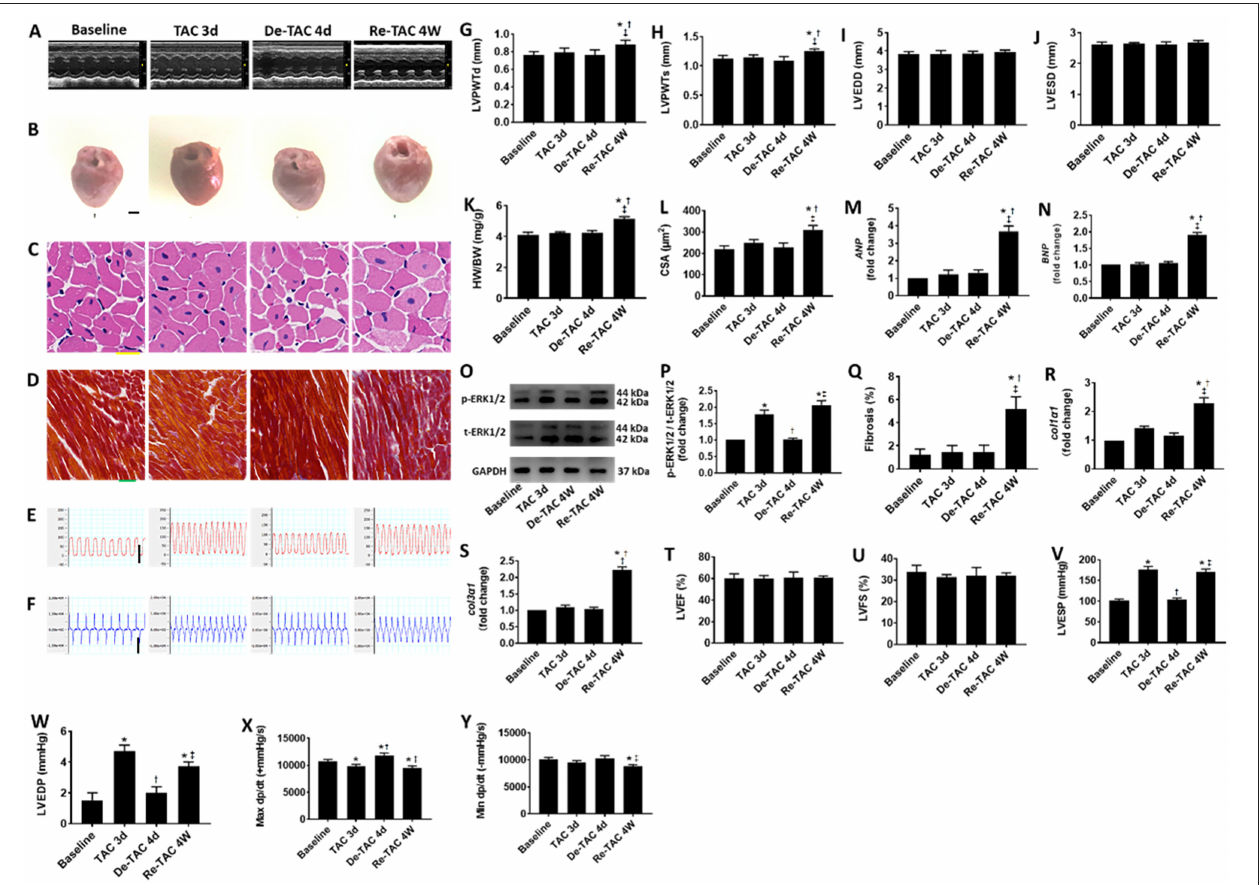
FIGURE 3 | Serial assessment of cardiac morphological and functional changes in HP murine hearts. (A) M-mode echocardiography of LVs at baseline, 3 days after TAC (TAC 3d), 4 days after de-banding (De-TAC 4d), and 4 weeks after re-banding (Re-TAC 4W). (B) Gross appearance of hearts. Scale bar = 1mm. (C) Cardiomyocytes stained by H&E. Scale bar = 20 µ m. (D) Cardiac fibrosis stained by Masson’s trichrome. Scale bar = 50 µ m. Representative images of (E) LV pressure and (F) dp/dt. Scale bar = 100 mmHg for pressure, scale bar = 10,000 mmHg/s for dp/dt. (G) LVPWTd. (H) LVPWTs. (I) LVEDD. (J) LVESD. (K) HW/BW. (L) CSA of cardiomyocytes. (M,N) Real-time quantitative PCR analyses for the gene expression of ANP and BNP , respectively. Representative images (O) and densitometric assessment (P) of Western blot for ERK1/2 activation. (Q) Quantification of collagen staining expressed as % area. Gene expression of makers of cardiac fibrosis (R) col1 α 1 and (S) col3 α 1 . Echocardiographic measurements of (T) LVEF and (U) LVFS. Invasive hemodynamic assessment of (V) LVESP, (W) LVEDP, (X) Max dp/dt, (Y) Min dp/dt. * P < 0.05 vs. Baseline; † P < 0.05 vs. TAC 3d; ‡ P < 0.05 vs. De-TAC